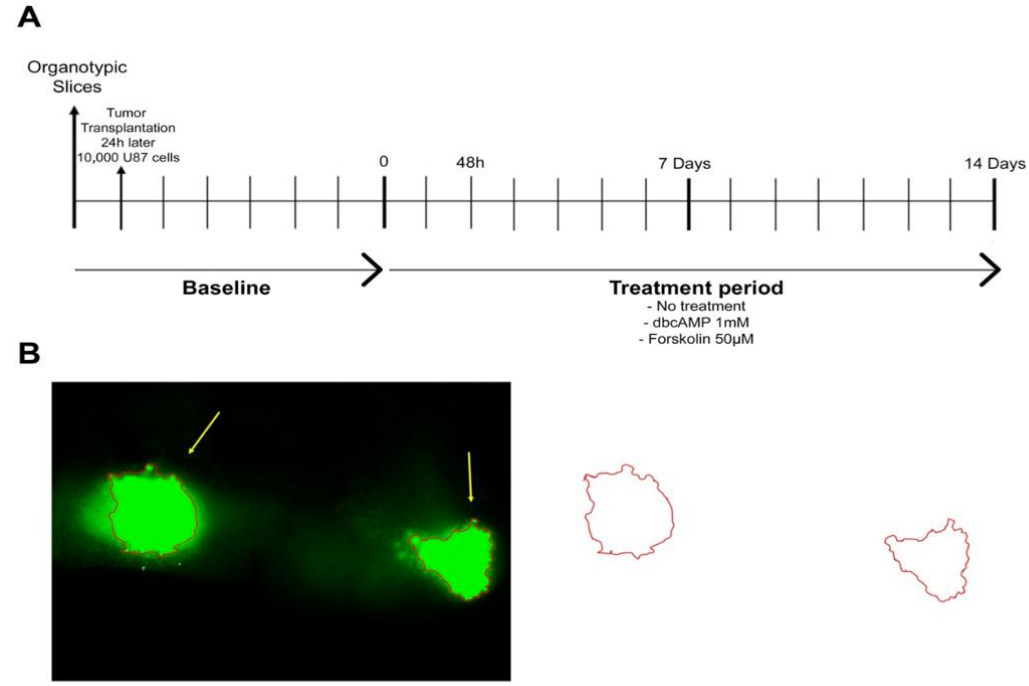
Figure 1. Experimental design. ( A ) Timeline. U87GFP+ cells (10,000 cells/0.1 µ L medium) were implanted bilaterally into the CA3 region of the hippocampus 24 h after organotypic brain slice culture preparation. One intersection represents 24 h resp. 1 day. ( B ) Quantification of the tumor